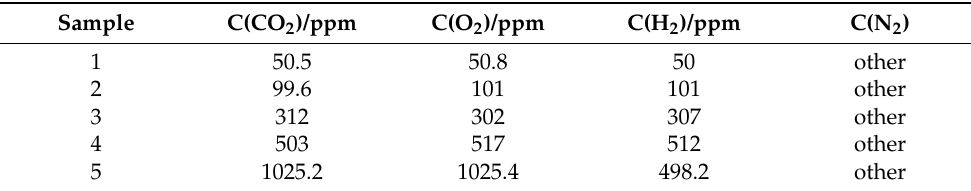
Table 2. Composition and content of gas